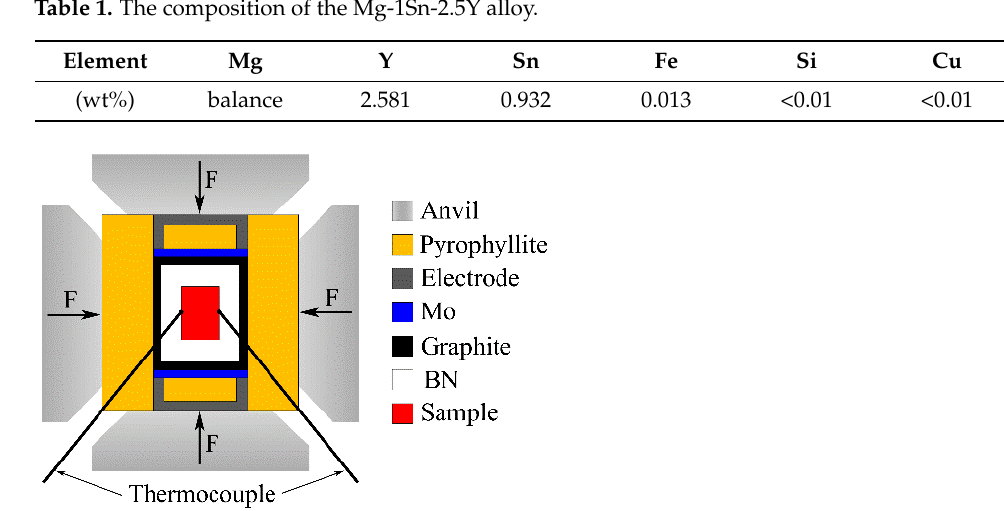
Figure 1. Schematic diagram of the high pressure solidification